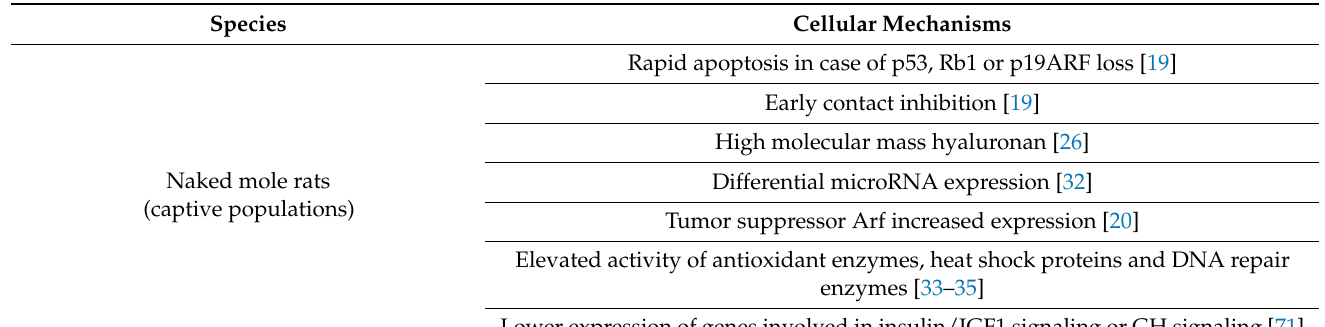
Table 1. Species and their cellular mechanisms conferring protection against